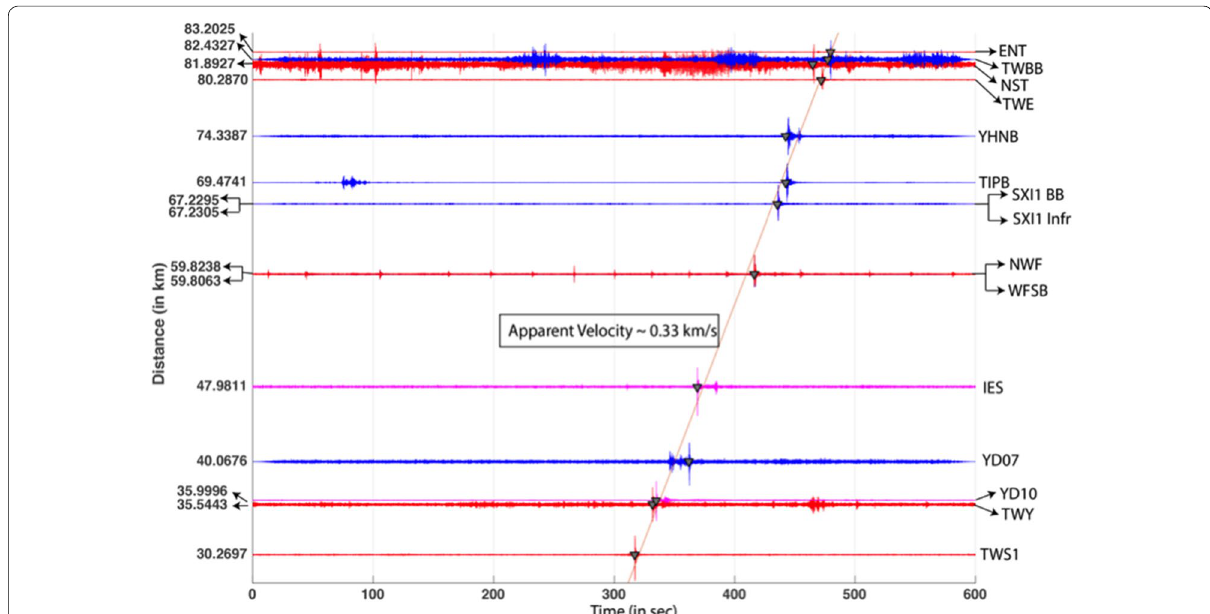
Fig. 3 The waveforms record at the seismic ( Red CWB; Blue BATS) and infrasound ( Magenta IES) stations used in the study. The amplitudes are normalized to facilitate the visualization. The inverted triangles denote the arrival times of the shock waves. The slope of the arrival times is 0.33 km/s as determined using the least squares method (Additional file 1: Table